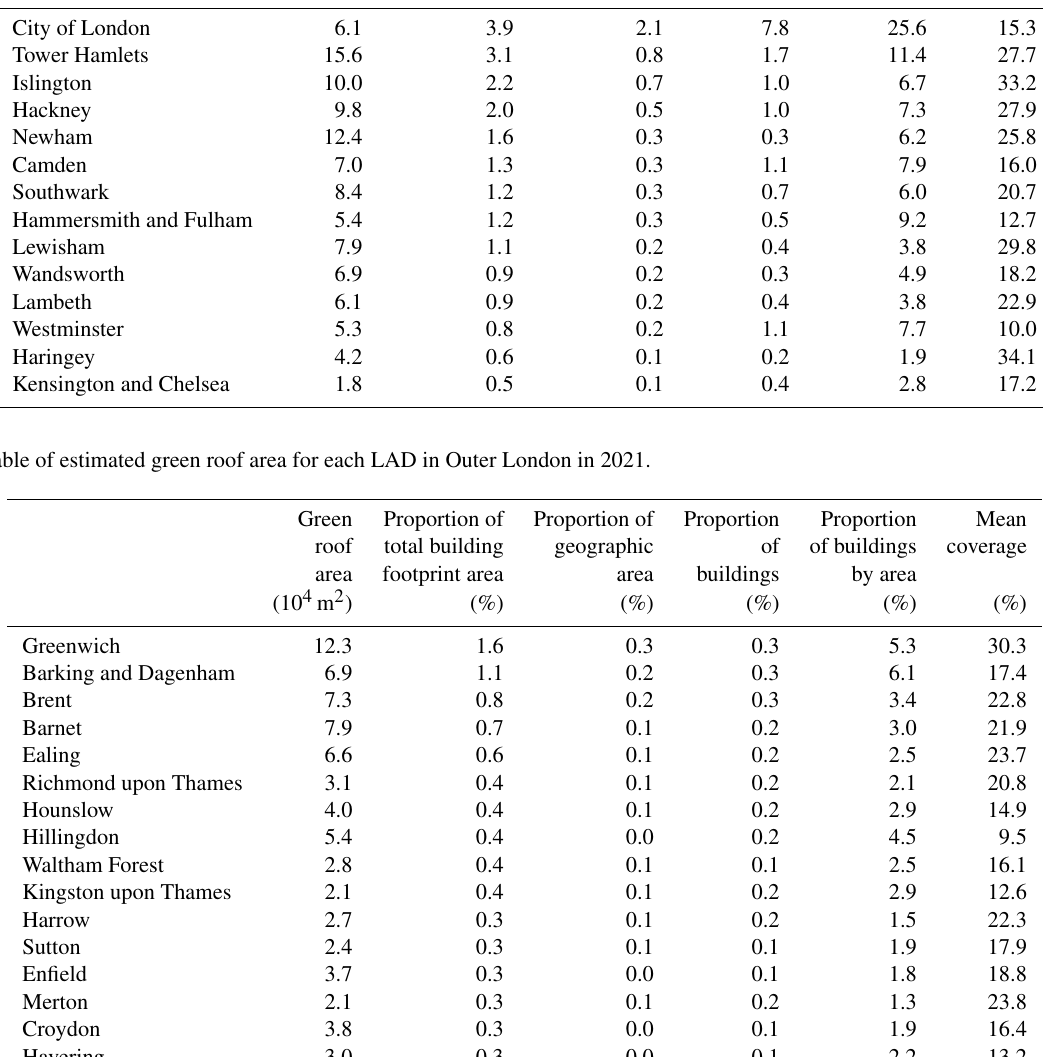
Table 7. Table of estimated green roof area for each LAD in Inner London in 2021. Green Proportion of Proportion of Proportion Proportion Mean roof total building geographic of of buildings coverage area footprint area area buildings by area (10 4 m 2 ) (%) (%)